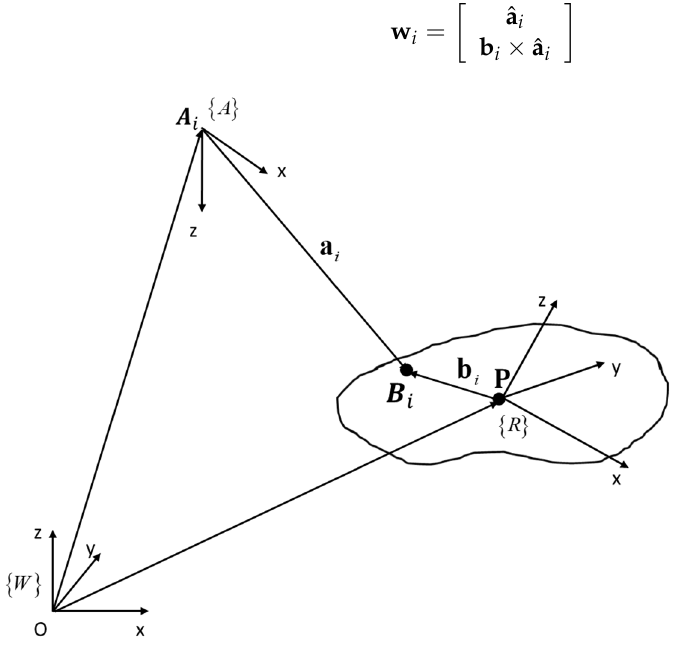
Figure 2. General kinematic model of CDPM.